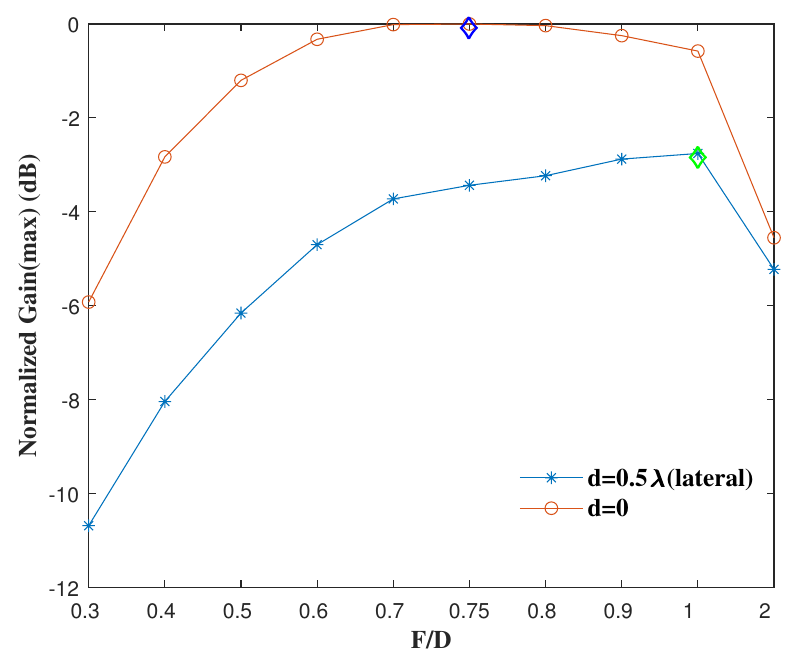
Figure 7. Peak gain of each F / D with d = 0.5 λ (lateral) and d = 0 (lateral).